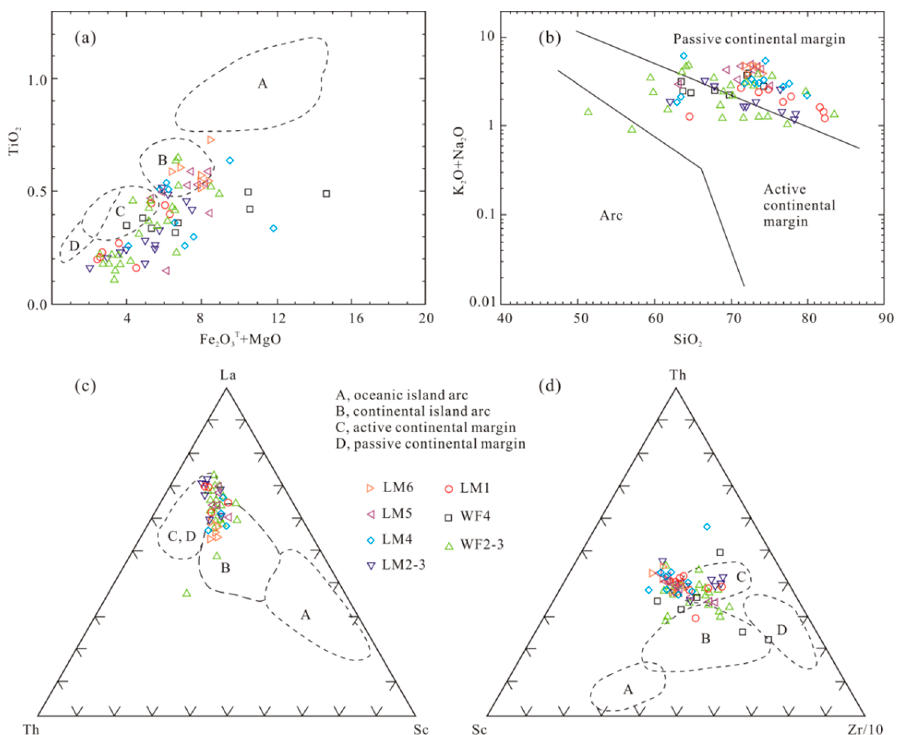
Figure 15. Tectonic setting discrimination diagrams for the Wufeng–Longmaxi shale on the Yangtze Platform, South China. ( a ) TiO 2 –Fe 2 O 3T + MgO (Bhatia, 1983), ( b ) K 2 O + Na 2 O–SiO 2 , ( c ) La–Th–Sc, and ( d ) Th–Sc–Zr/10 diagrams [75].